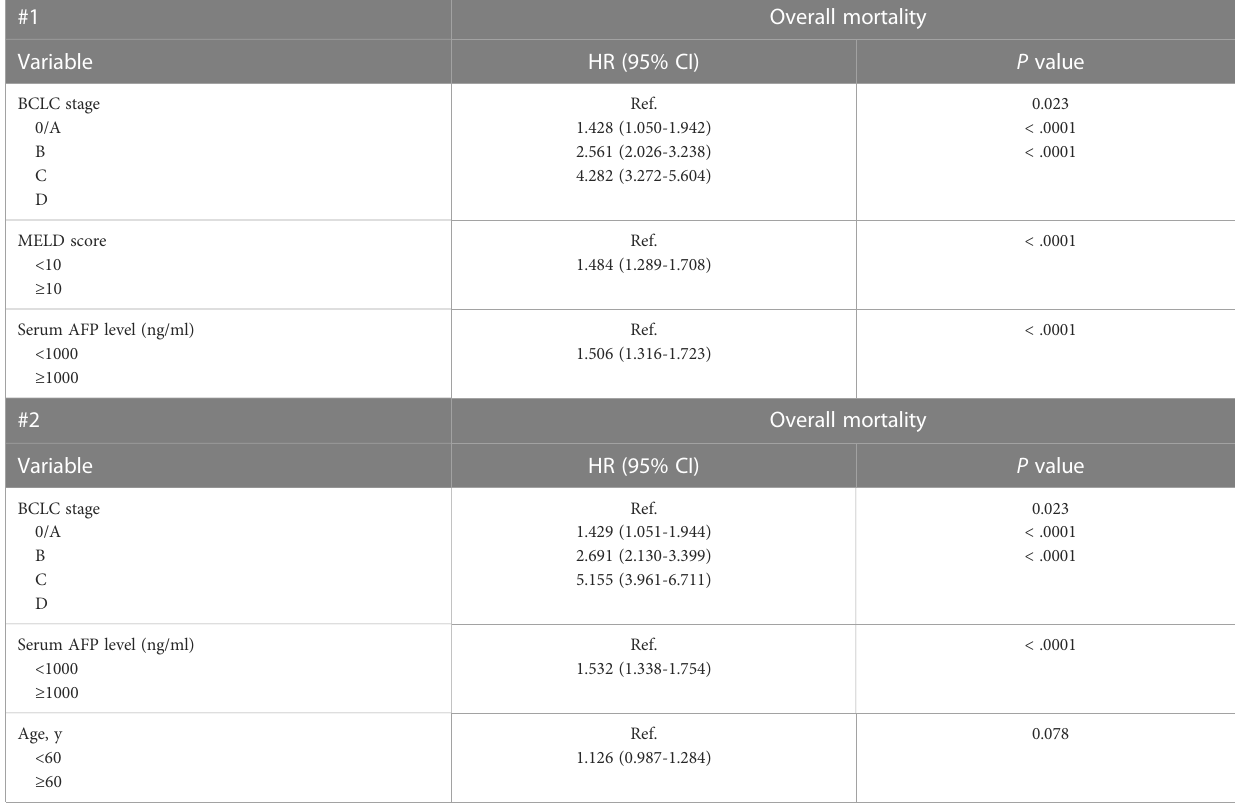
TABLE 3 Multivariate Cox Proportional Hazards Regression Models of Factors Associated with Mortality in 1045 Patients With Untreated HCC.